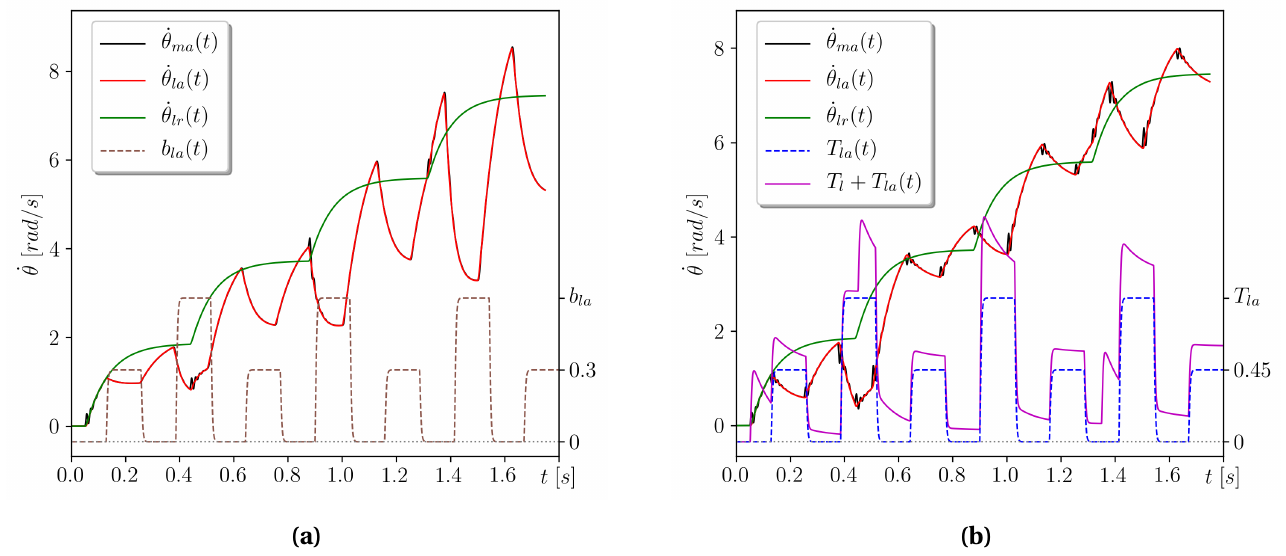
Figure 9. The open-loop reference model control system response at presence of the additional time-dependent disturbances of damping (a) b la ( t ) and loading (b) T la ( t ) (high frequency).